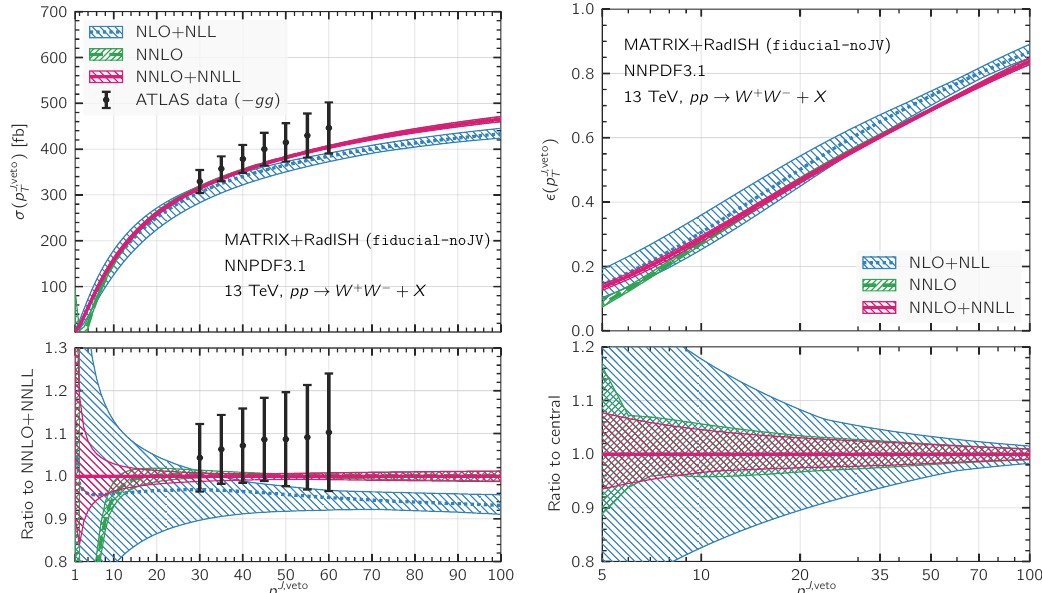
Figure 3 . Fiducial cross sections (left plot) and jet-veto efficiencies (right plot) as a function of the jet-veto cut at NLO+NLL (blue, dotted), NNLO (green, dashed), and NNLO+NNLL (red, solid). In the left plot, we also show the fiducial cross sections measured by ATLAS [75], from which we have subtracted the loop-induced gluon fusion contribution at LO that simply amounts to a constant shift independent of p J, veto (see text for T